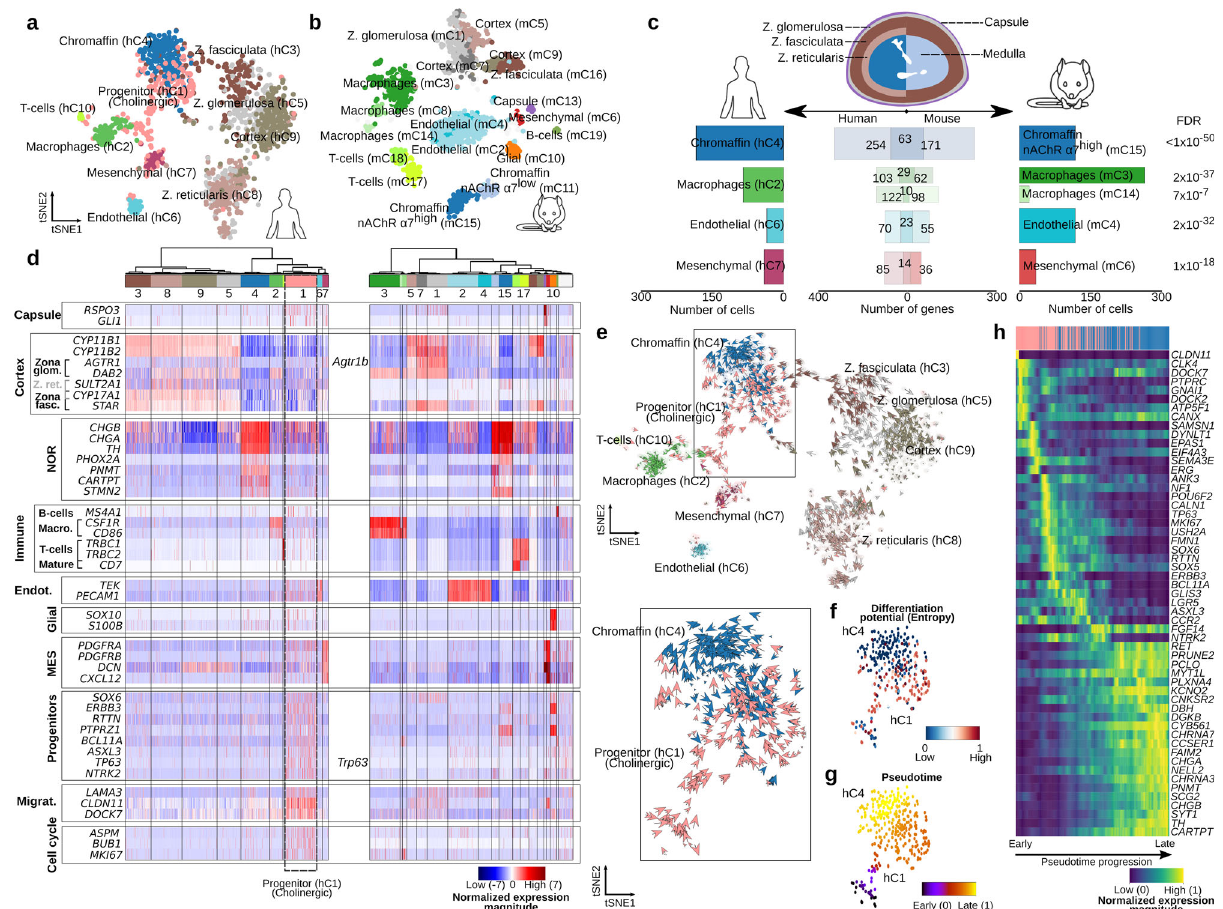
Fig. 1 Anatomy of human and mouse adrenal gland (AG) revealed from single nuclei/cell analysis. a 1536 single nuclei of human AG from three different patients were sequenced with Smart-seq2 to an average depth of 485,000 reads per cell. Cells with high-quality ( n = 1322) were selected and further processed with PAGODA. Cells were grouped into ten different clusters, including cortex (in brown and gray colors), chromaf fi n (blue hC4), mesenchymal (purple hC7), endothelial (light blue hC6), and immune cells (i.e., T cells hC10 and macrophages hC2 in green colors). b 1920 single cell of mouse AG from fi ve different samples were sequenced with Smart-seq2 to an average depth of 670,000 reads per cell. Cells with high-quality ( n = 1763) were selected and further processed with PAGODA. Cells were grouped into nineteen different clusters, including cortex (in brown and gray colors), chromaf fi n (blue mC15 and light blue mC11), mesenchymal (red mC6), capsule (purple mC13), endothelial (light blue mC2 and mC4), glial (orange mC10), and immune cells (i.e., T cells mC17 and mC18, and macrophages mC3, mC8, and mC14 in green colors). Human and mouse adrenal glands zonation 49 is illustrated in ( c ). c , d A comparison of the speci fi c gene signature between human and mouse revealed similar transcription signatures for mesenchymal, endothelial, and immune clusters, nevertheless, the two different postnatal chromaf fi n cells could only be differentiated in mouse. d Hierarchical clustering of cells and expression of a panel of markers including noradrenergic (NOR), mesenchymal (MES), endothelial (Endot.), and migratory (Migrat.). e – g A population of cells with a signi fi cant high expression of progenitor markers (i.e., SOX6 , ERBB3 , RTTN , FDR<0.01) and high differentiation potential found uniquely in human AG, is sourcing the chromaf fi n cells as indicated by velocity, entropy, and pseudotime analyses. h In this process, gene expression elapses from an undifferentiated stem-like- (i.e., RTTN + ) to an adrenergic signature ( PNMT + ), passing by a noradrenergic stage (i.e., DBH + ), as indicated by the pseudotime of the underlying cellular process. Results in ( c ), ( e ), and the top inserts in ( d ) and ( h ) represent cell clusters by color in ( a